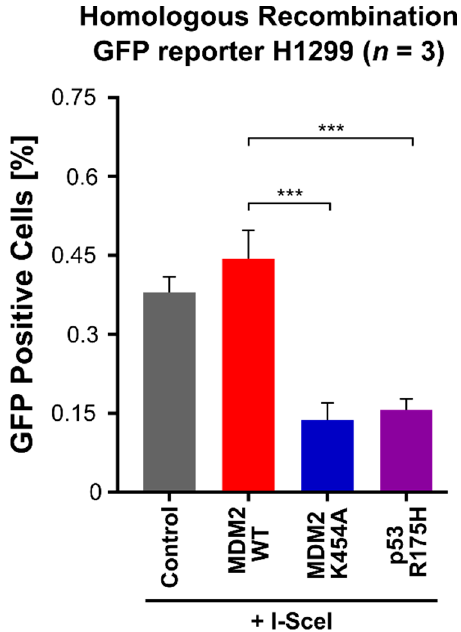
Figure 5. Analysis of homologous recombination DNA repair efficiency. Homologous recombina- tion GFP reporter assessment after overexpression of MDM2 WT, MDM2 K454A, and p53 R175H. Statistical significance was assessed by comparing MDM2 WT overexpression with other samples, *** p < 0.001. n —the number of independent experiments